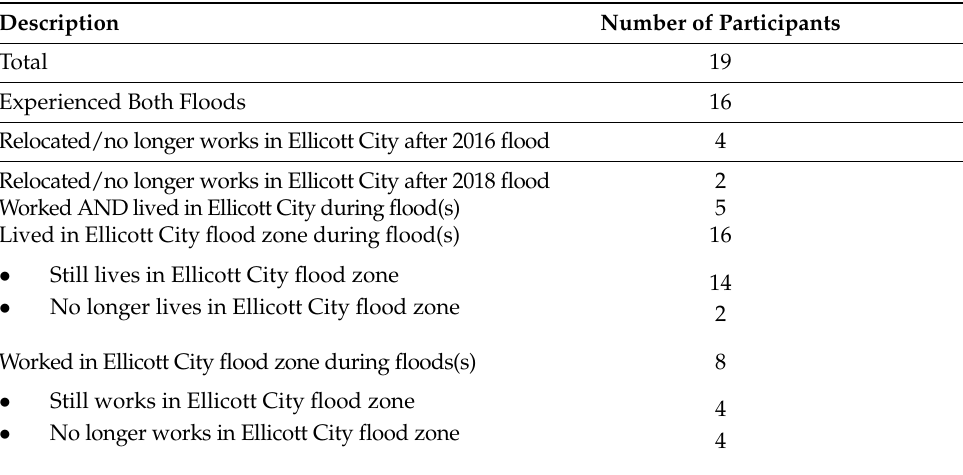
Table 1. Summary of